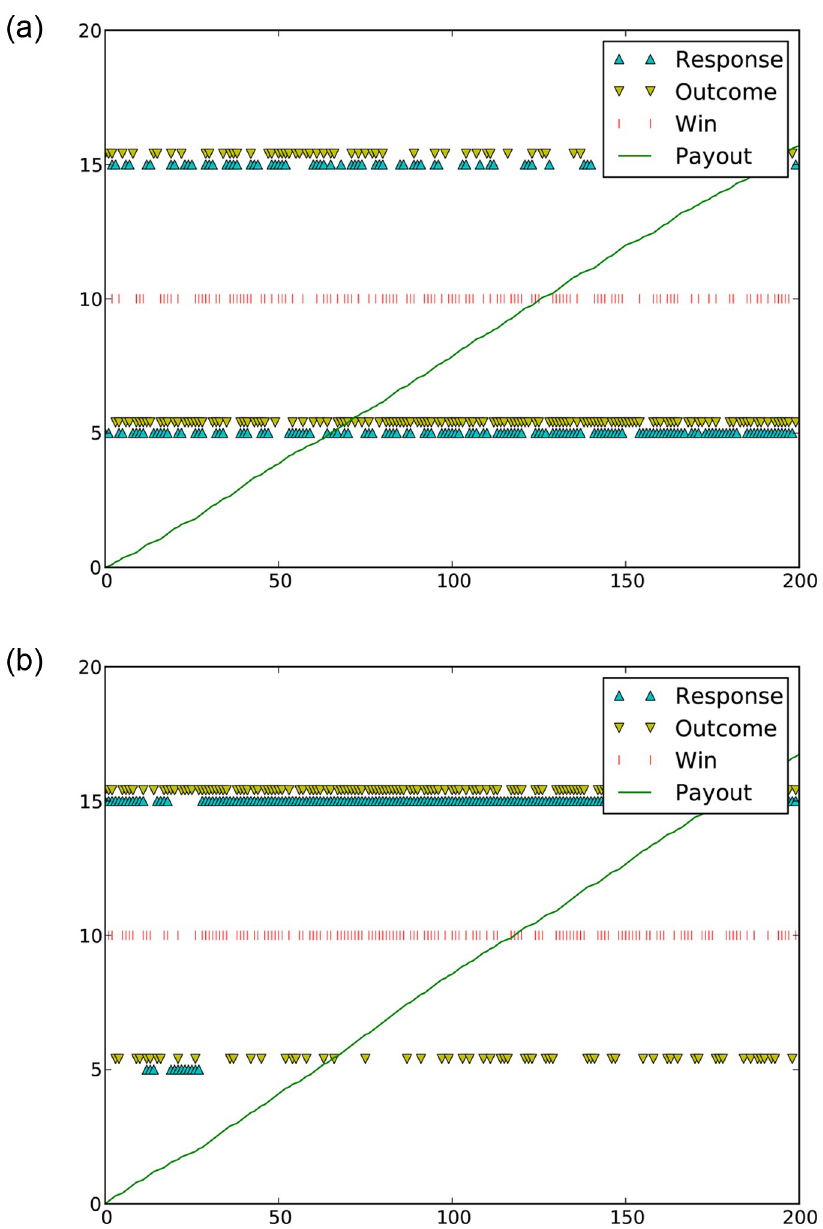
Fig 3. Experimental outcomes for a representative randomizer (3a) and a representative maximizer (3b). The highest row of triangles displays the randomly generated appearances of Angelina Jolie for each trial. The second row of triangles displays the instances when the subject’s response was Angelina Jolie. The bottom two rows of triangles represent the same information for Brad Pitt appearances and Brad Pitt responses. The middle row of red ticks represents trials that the subject guessed correctly. The diagonal line shows the cumulative payout to the subject over